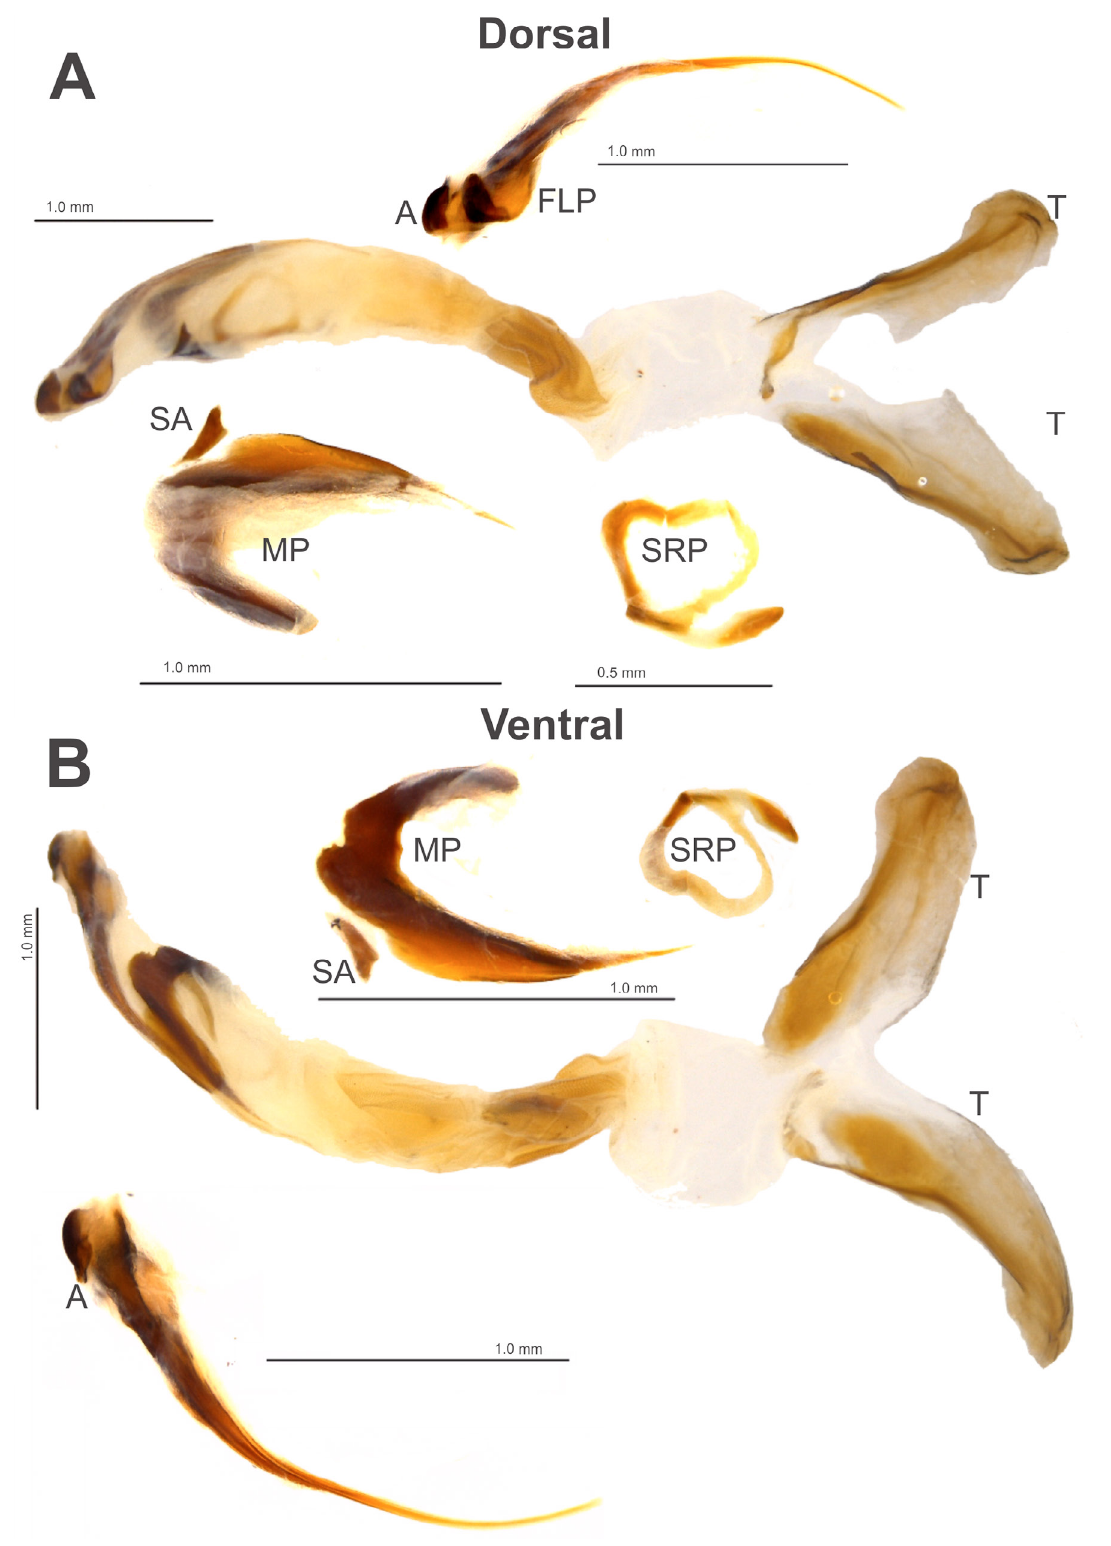
Fig. 9. Canthon ( Peltecanthon ) terciae sp. nov., paratype, ♂, Rio Grande do Norte, Baia Formosa, Mata Estrela (CEMT). Position of the internal sac sclerites. A . Dorsal view. B . Ventral view. Abbreviations: see Material and